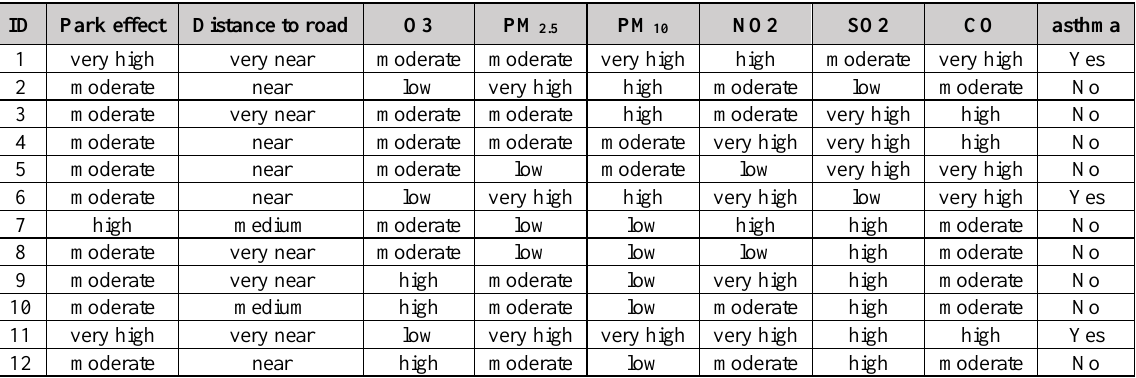
Table 2. Part of the multidimensional dataset used in association rule